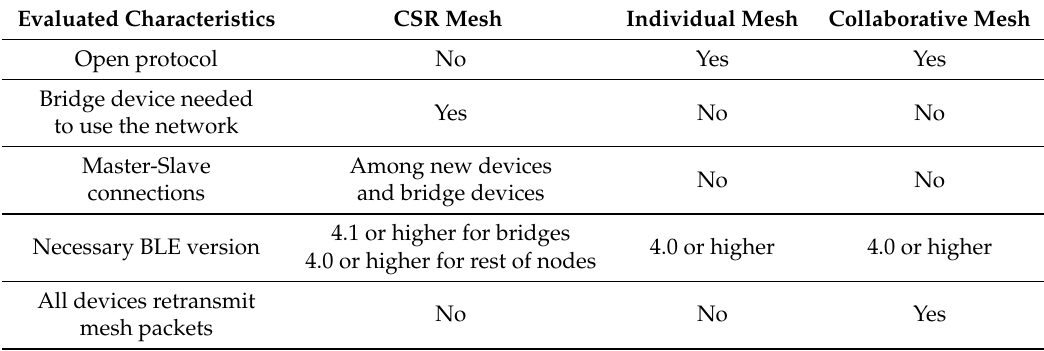
Table 19. Differences between CSR Mesh protocol, Individual Mesh and Collaborative Mesh